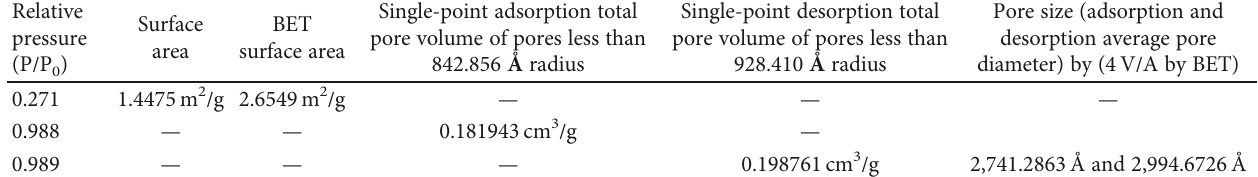
Table 2: The values of surface area and pore volume for poly(4,4 ′ -cyclohexylidene bisphenol oxalate).